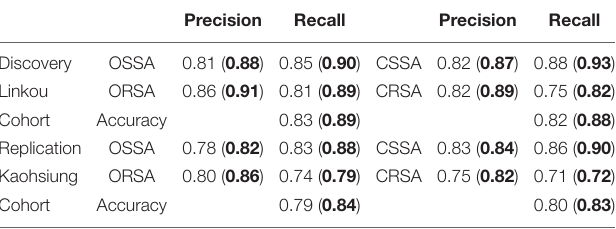
TABLE 5 | Evaluation of partial susceptibility prediction in discovery and replication cohort. Precision Recall Precision Recall